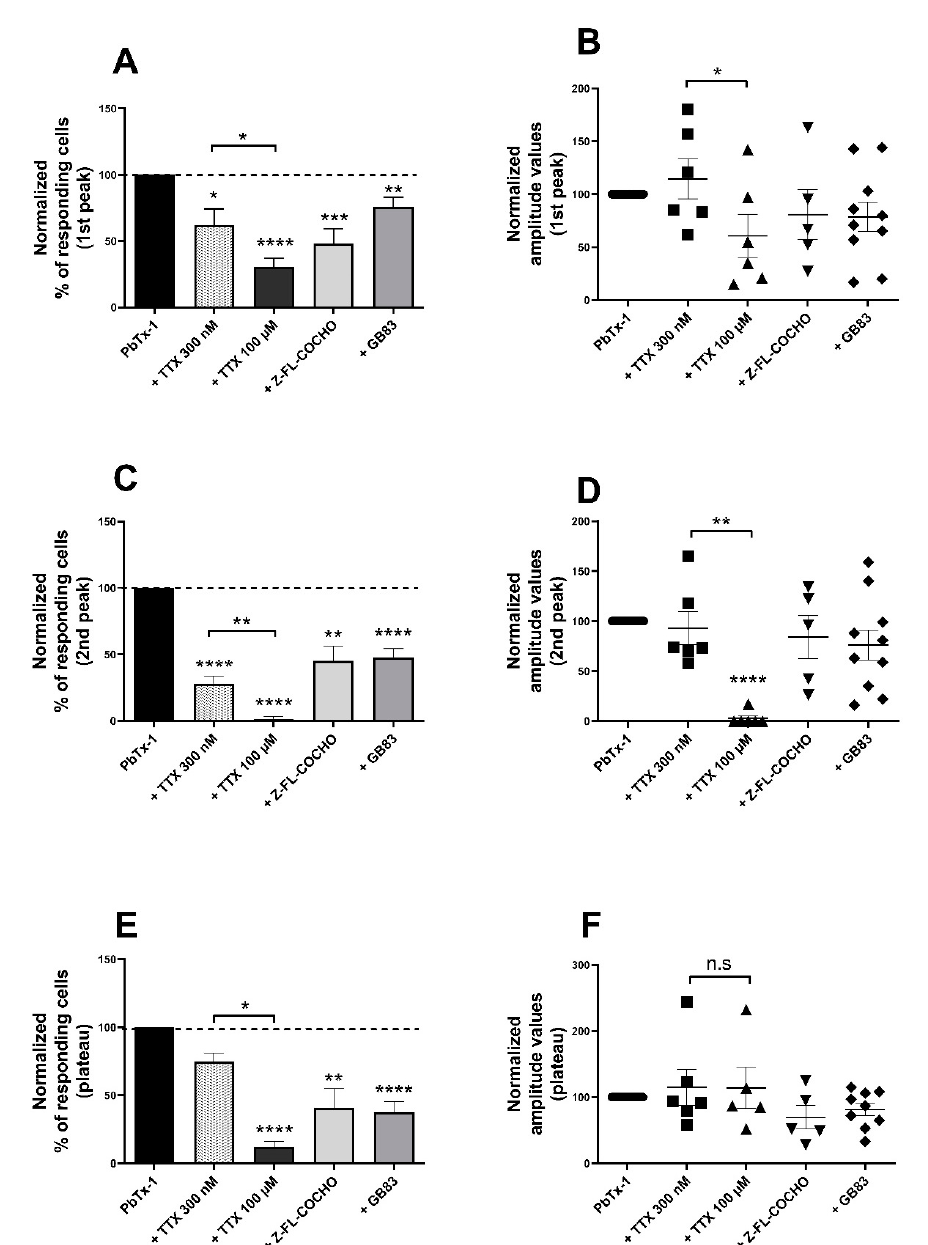
Figure 2. Na v channels (TTX-s and TTX-r), Cat-S and PAR2 mediate PbTx-1-induced [Ca 2 + ] i increase in sensory neurons. Normalized percentages of responding cells and normalized average amplitude values were recorded for the first transient ( A , B ), the second transient ( C , D ), and the plateau ( E , F ) in response to 1 µ M of PbTx-1 alone (control condition, considered 100%, n = 15) or with pre-treatment with 300 nM of TTX ( n = 6), 100 µ M of TTX ( n = 6), 10 nM of Z-FL-COCHO ( n = 9) and 5 µ M of GB83 ( n = 9), expressed as mean ± SEM. The “ n ” represents the number of experiments in which 50 to 150 neuronal cells were included in the analysis. In the right panel, each symbol represents the normalized mean of the maximal amplitude values from the responding neurons obtained in each experiment. Statistical analysis was performed with a Kruskal–Wallis followed by Dunn’s test for multiple comparisons between control and each condition, and Mann–Whitney between the condition pre-treatment with TTX 300 nM and the condition pre-treatment with TTX 100 µ M. * p < 0.05, ** p < 0.01, *** p < 0.001 and **** p < 0.0001. [Ca 2 + ] i : intracellular calcium concentration; Cat-S: cathepsin S; Na v : voltage-gated sodium channel; ns: non-significant; PAR2: protease-activated receptor 2; PbTx-1: brevetoxin-1; TTX: tetrodotoxin; TTX-r: TTX-resistant; TTX-s: